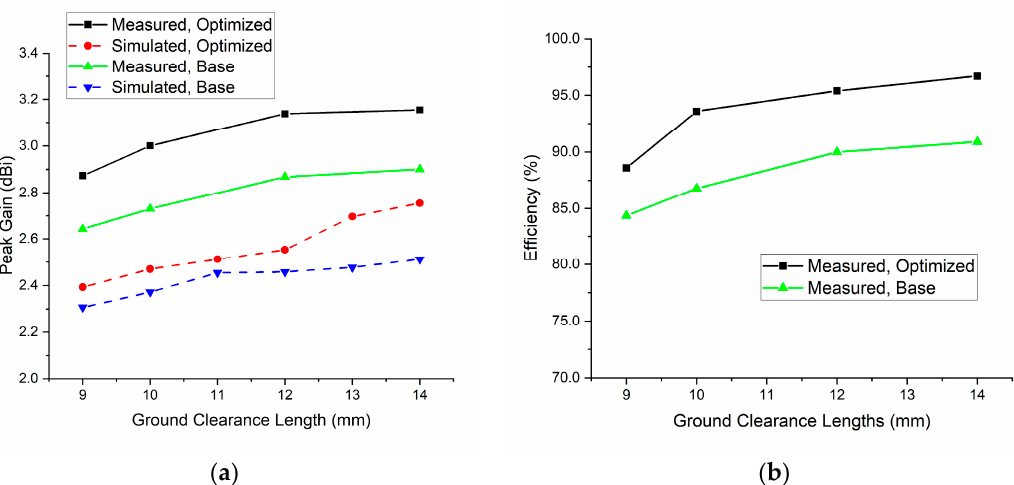
Figure 10. Comparison of ( a ) the simulated and measured peak gain and ( b ) the measured efficiencies of the base and DH-BPSO-optimized IFAs.